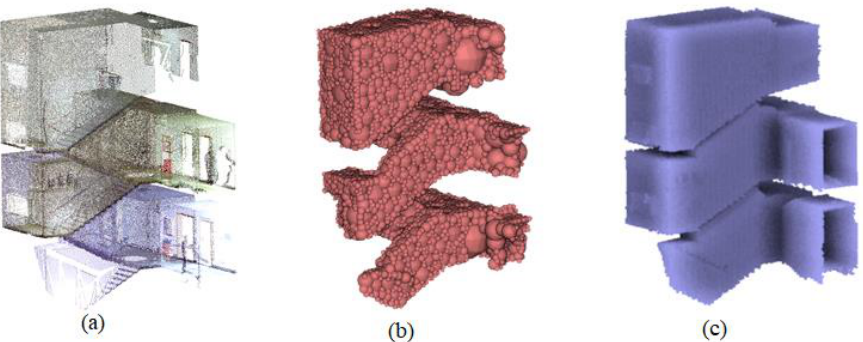
Figure 8. The sphere packing and segmentation results for stairs; the stair area and floors are connected as a whole. ( a ) Original point cloud of the stair region; ( b ) sphere packing result; ( c ) room segmentation result for the case in which the stair area and floors are connected as a whole.